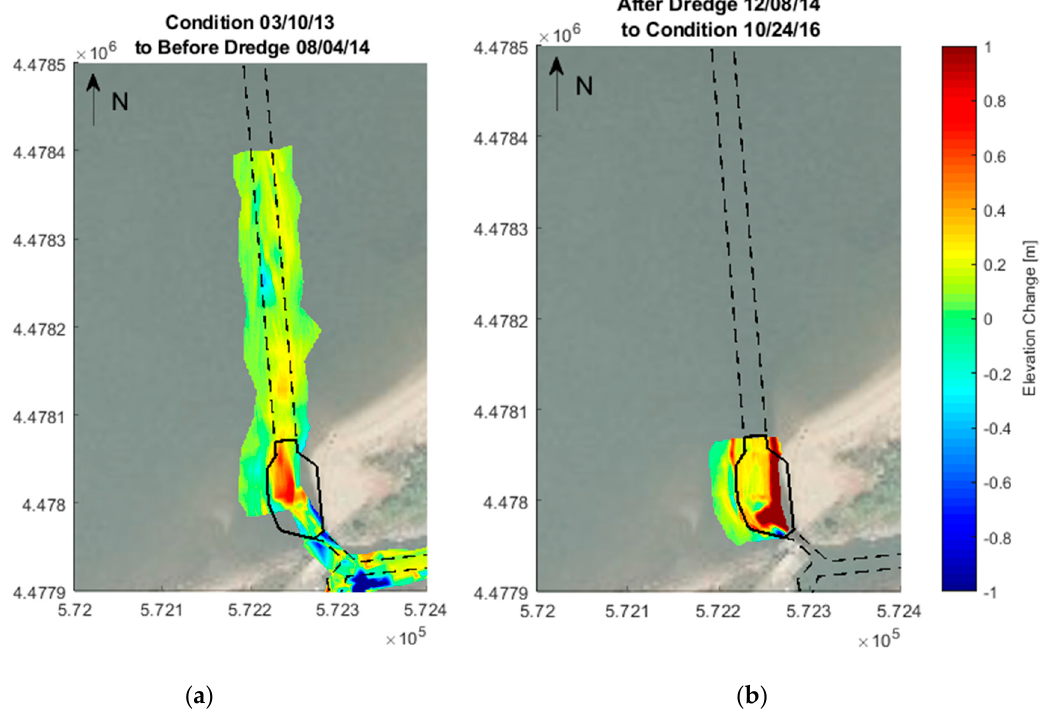
Figure 3. Elevation difference plots for two surveys within ( a ) design template footprint represented as a black dotted line and ( b ) partial dredging inlet throat smaller area for volume calculations as black solid line.